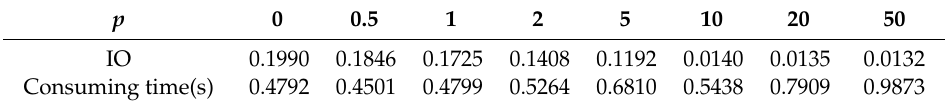
Table 3. Index of orthogonality (IO) and consuming time versus di ff erent values of pole parameter